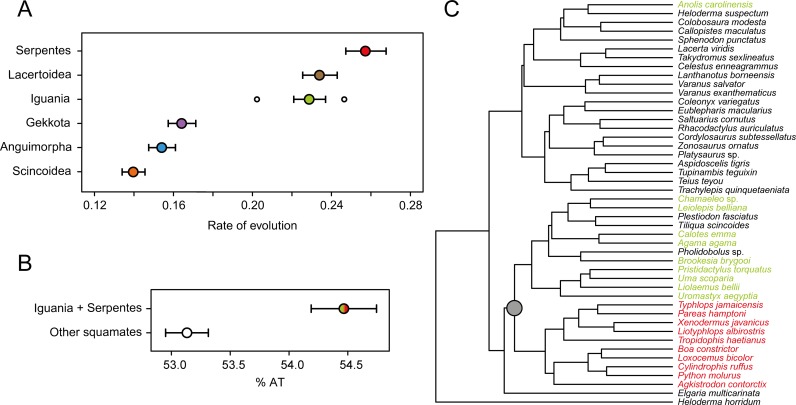
Systematic biases in the molecular dataset.A. Inferred rate of evolution for each of the main clades of lizards studied. Both the median and 95% confidence intervals are represented. In the case of Iguania, the white dots also show the median values for the rate of evolution estimated individually for Acrodonta (right) and Iguanidae (left). B. Nucleotide composition of snakes and iguanians differs systematically from that of the remaining squamates. Values correspond to the average percentage of AT ± 1 standard deviation. C. Clustering of snakes and iguanians (grey dot) due to similar patterns of AT skewness. The tree represents a hierarchical clustering dendrogram, estimated using Euclidean distances of AT skewness per gene.